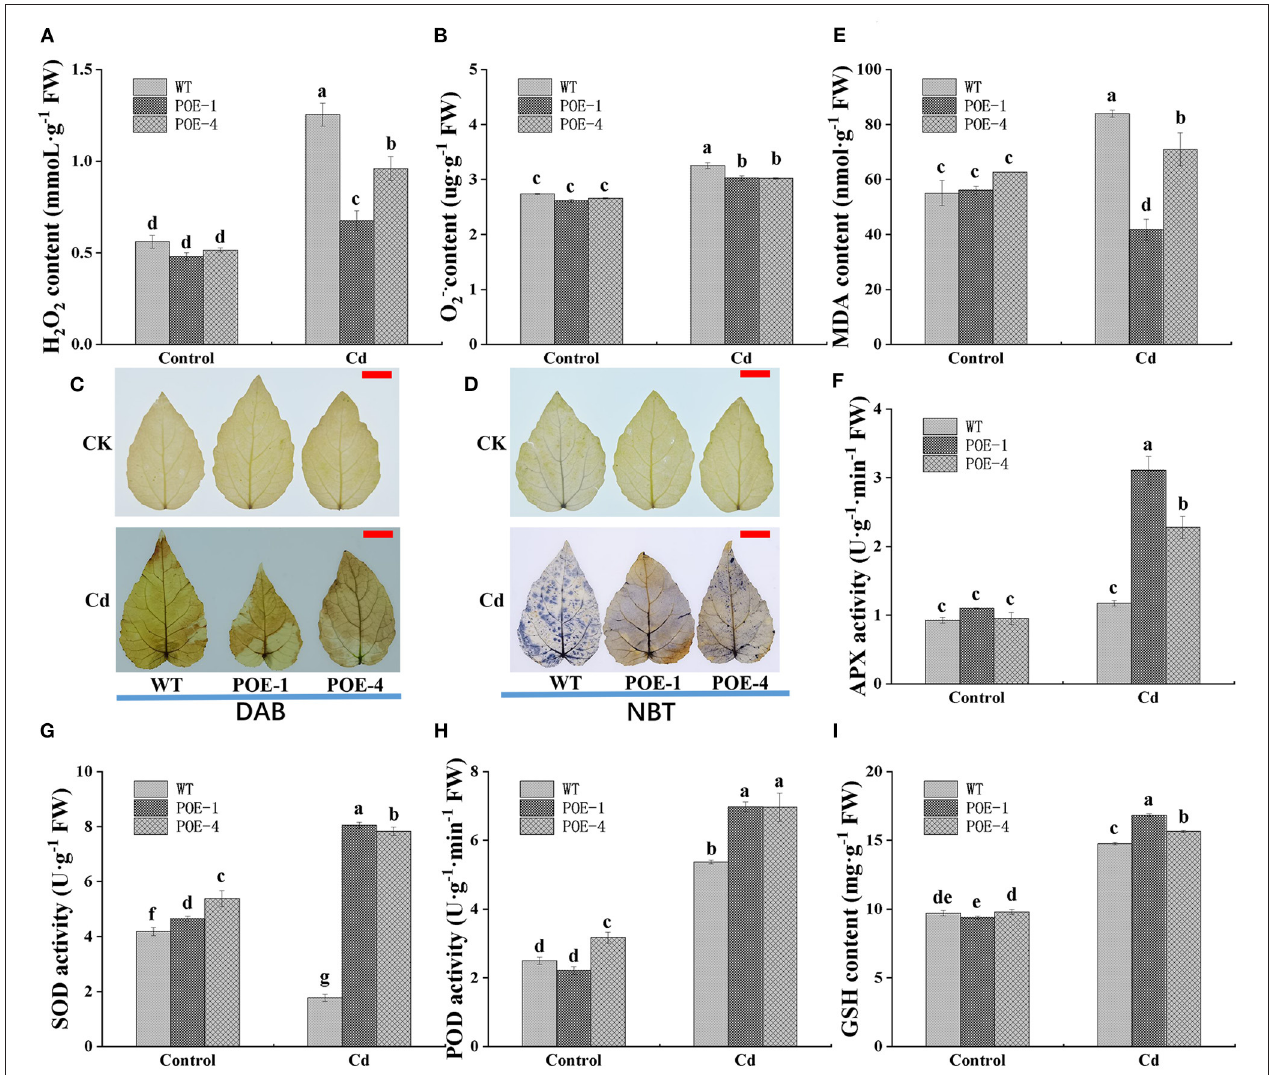
FIGURE 8 | PscCYP716A1 weakens the oxidative damage and enhances the antioxidant capacity of poplar under Cd stress. (A) Superoxide anion (O − . 2 ). (B) H 2 O 2 content. (C,D) NBT staining of O − . 2 and DAB staining of H 2 O 2 ; bar = 2cm. (E) Malondialdehyde content. (F) The activity of ascorbate peroxidase. (G) The activity of superoxide dismutase. (H) The activity of peroxidase. (I) The content of reduced glutathione. WT, wild type poplars; POE-1 and POE-4, PscCYP716A1 -overexpression poplars. All data are shown as the mean ± SD of three biological duplicates. Different letters indicate significant differences ( p < 0.05) between